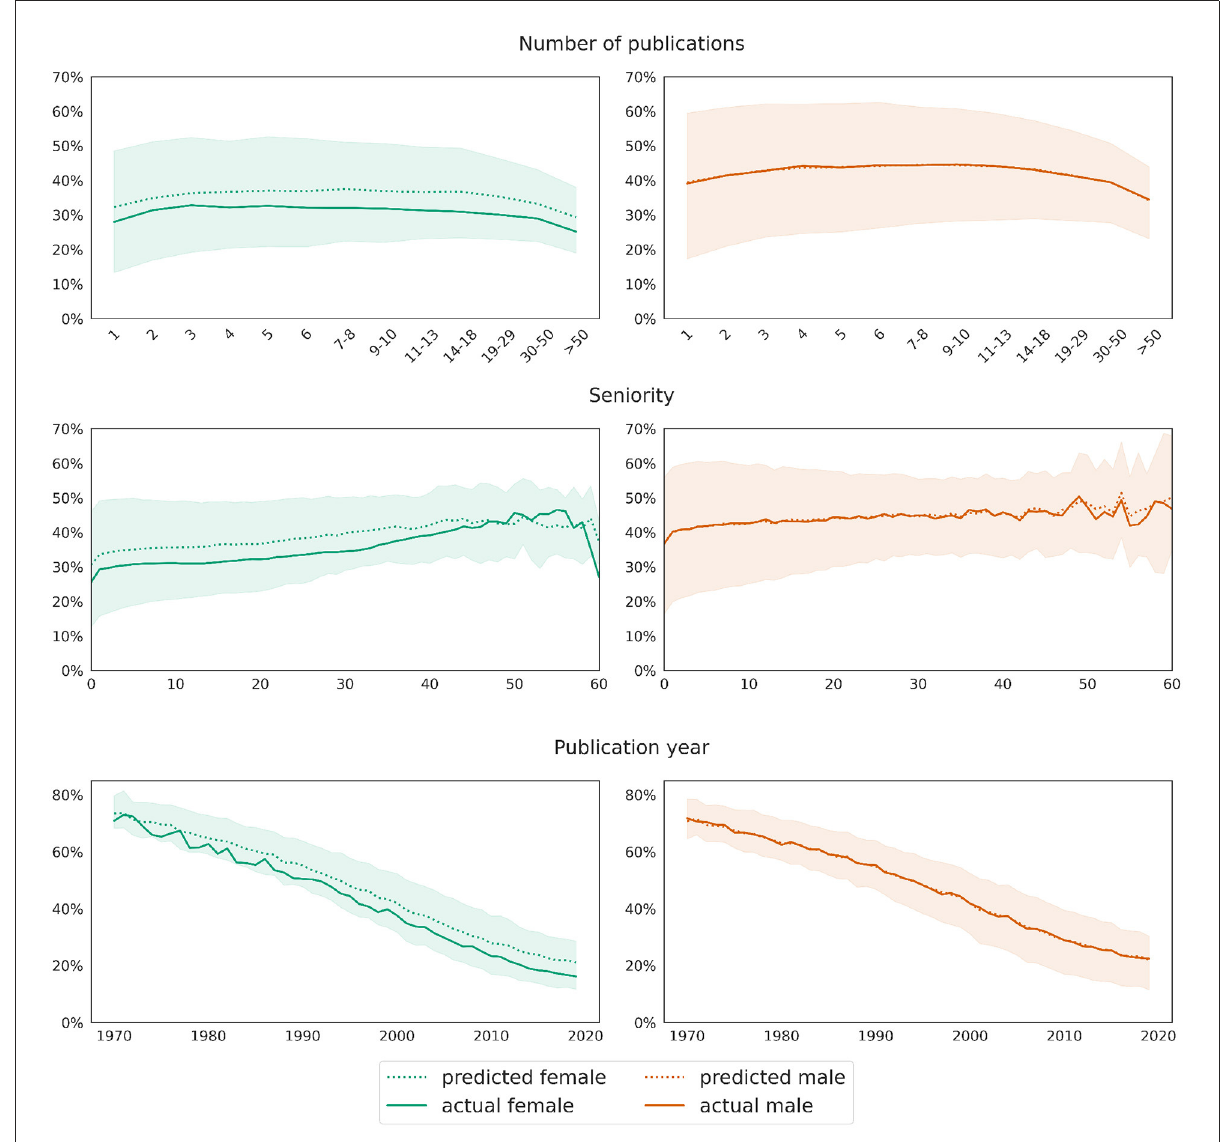
FIGURE9 Male baseline approach: Mean differences between actual (solid curve) and predicted (dotted curves) values for the target variable number of single authorships . Shaded areas mark the [25,75] confidence interval of the ground truth data.